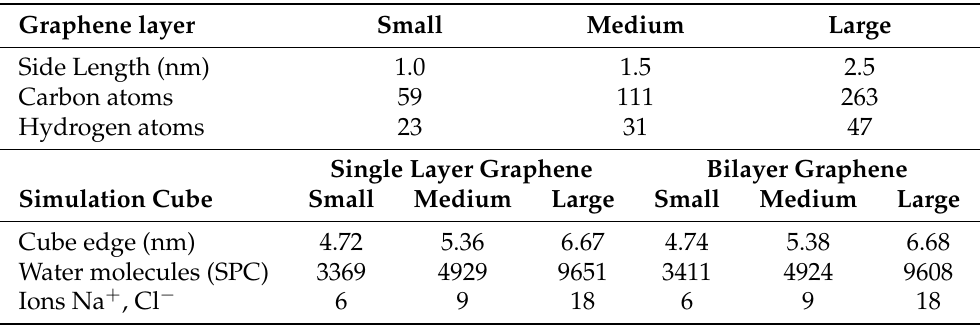
Table 1. Model properties of graphene layers with small, medium and large size, edge lengths of the simulation cubes and the number of solvent molecules (water and ions) contained in the cubes for the single and bilayer graphene